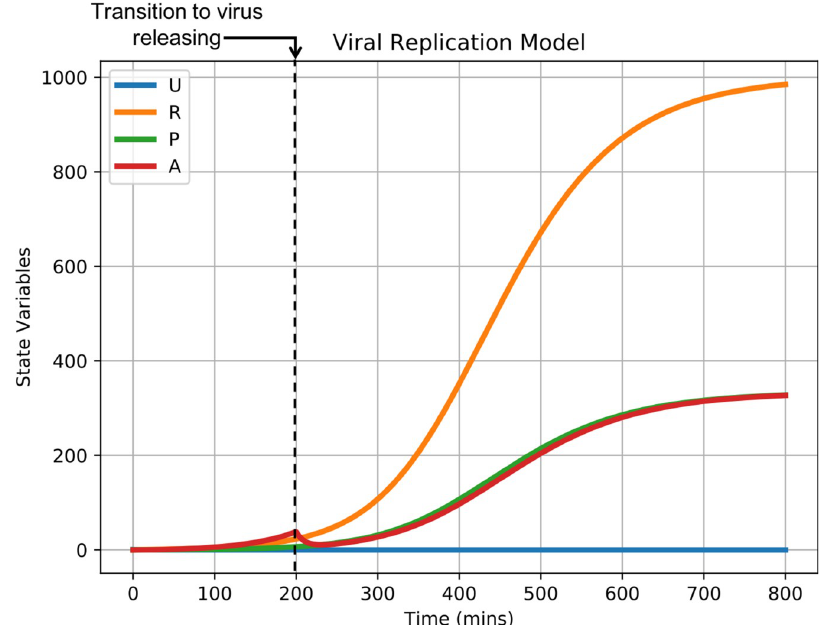
Fig 16. Representative time series of viral internalization, replication and release models from Fig 2B. A sample simulation of the viral replication model in a single epithelial cell. The model is initialized with one unit of internalized virus (U = 1), and the rest of the state variables set to zero (R = 0, P = 0, A = 0). No additional virus internalization occurs during this sample simulation. Dashed line indicates the time of the cell’s transition from the infected to virus- releasing cell